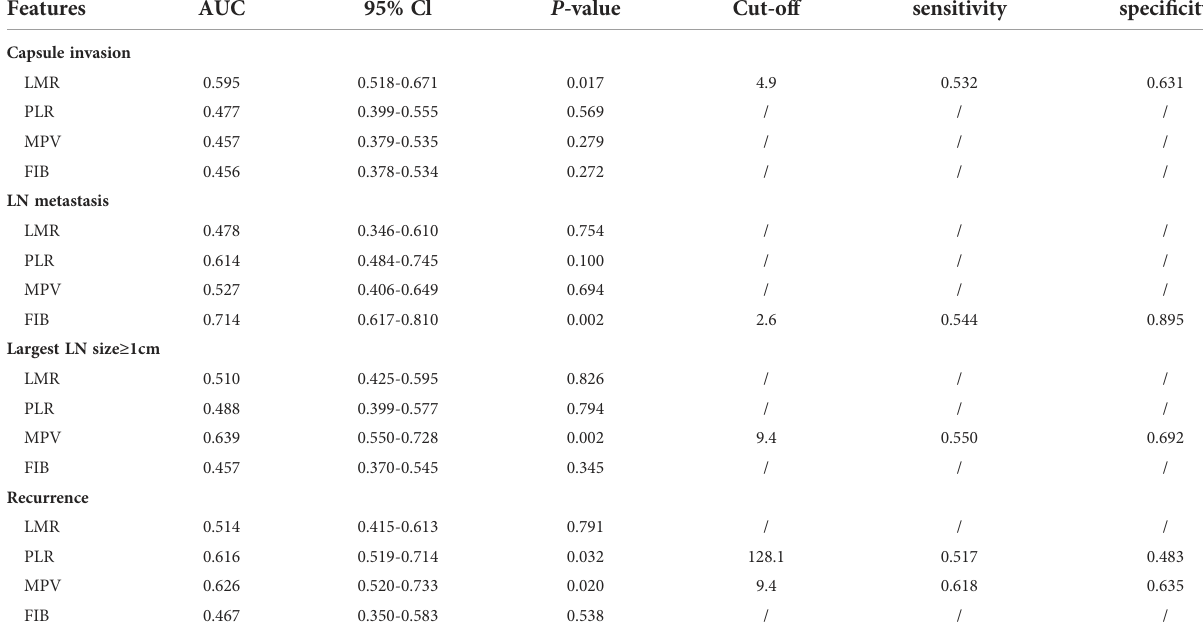
TABLE 2 The summary of area under the ROC curve.